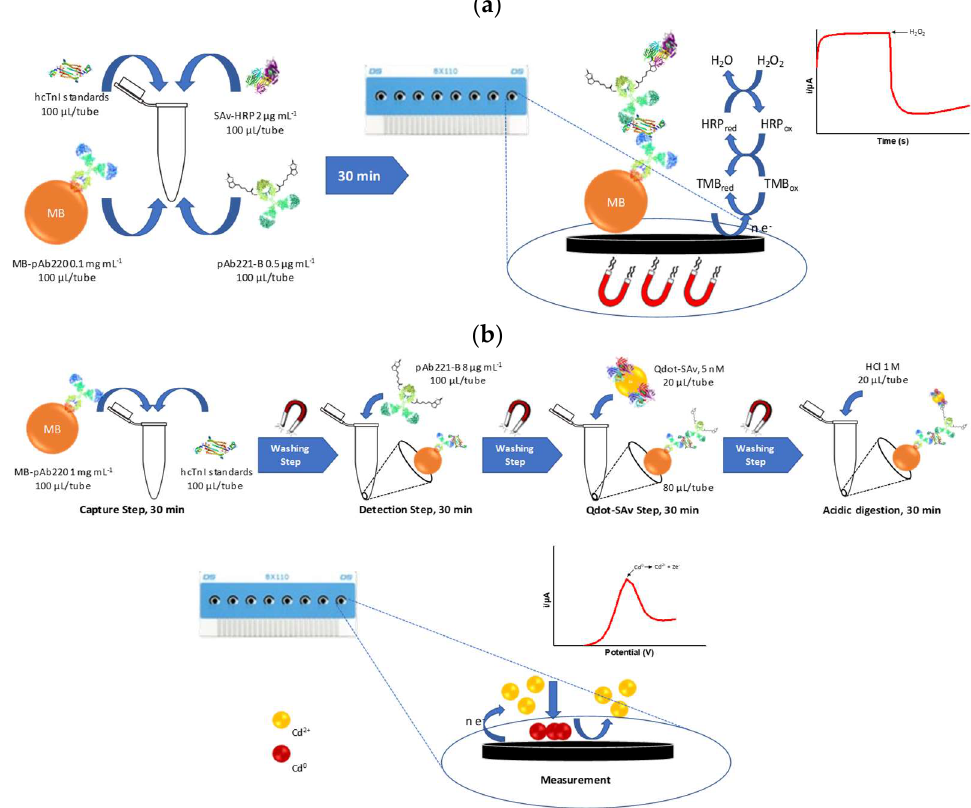
Figure 1. ( a ) Scheme of AMIS procedure. After all the biorecognition steps, the magnetic beads complex (MB-complex) was resuspended and immobilized onto the surface of the working electrode. Then, current intensity increased after substrate addition proportionally to the concentration of the hcTnI in the sample. ( b ) Scheme of the VMIS procedure. After all the biorecognition steps, the MB-complex was digested under acidic conditions provoking cadmium release from Qdot-SAv bioconjugates. Cadmium ions were placed in the electrochemical cell by magnetic rack separation. Then, deposition voltage was applied, and intensity of the peak was reached by square wave voltammetry